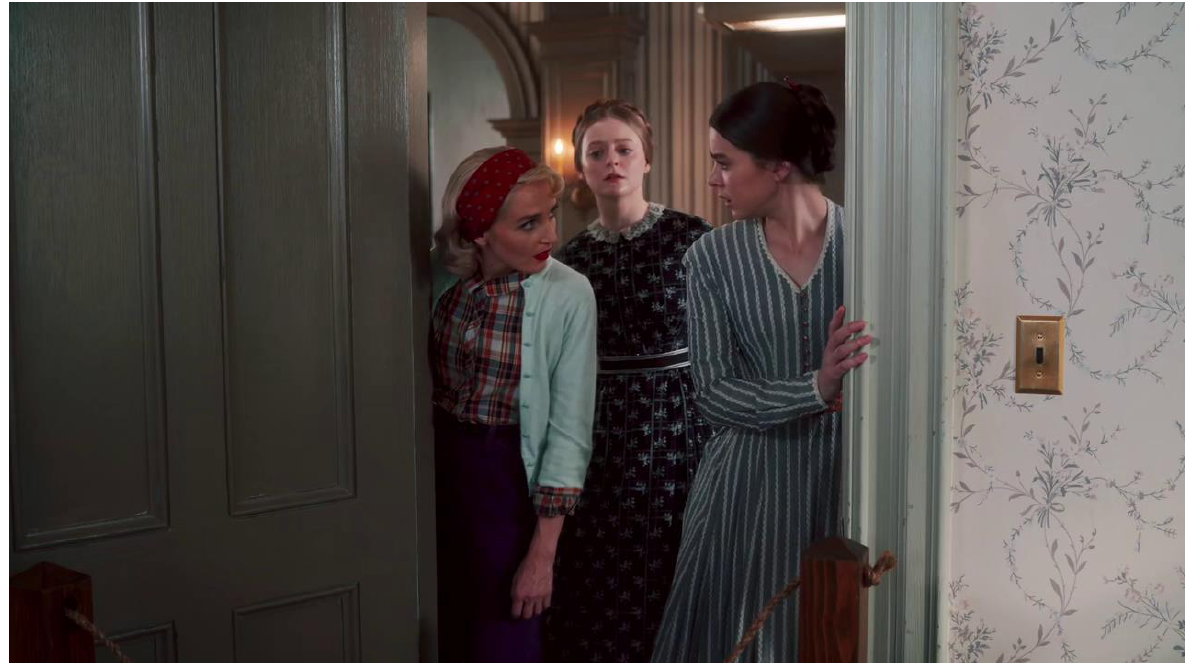
Figure 2. Emily and Lavinia Dickinson time travel to 1955, where they meet young Smith College student Sylvia Plath at their former home, now the Emily Dickinson Museum.